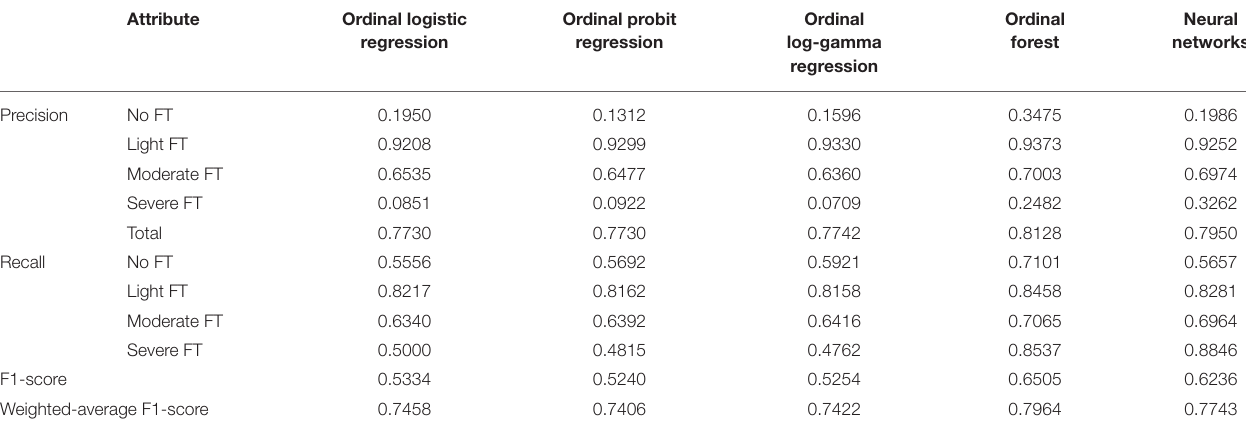
TABLE 3 | In-sample correct classification rate for each machine learning method.